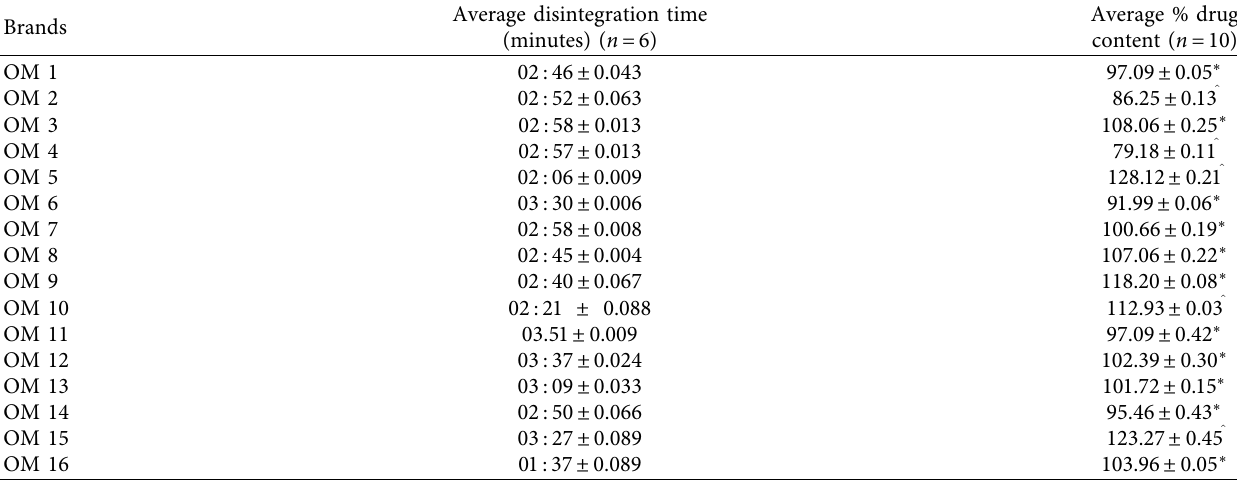
Table 3: Disintegration time and drug content of sampled brands.